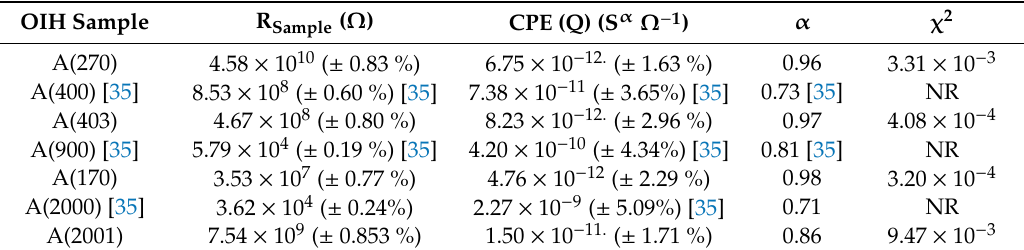
Table 1. Values of elements of the proposed EEC obtained from EIS data fitting of the OIH materials synthesized and errors in percentage. For comparison purposes the data reported for A(400) [35], A(900) [35], and A(2000) [35] were also